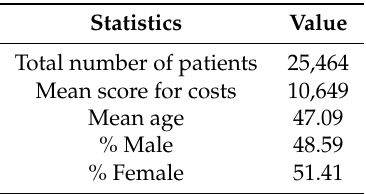
Table 1. Statistics of patients’